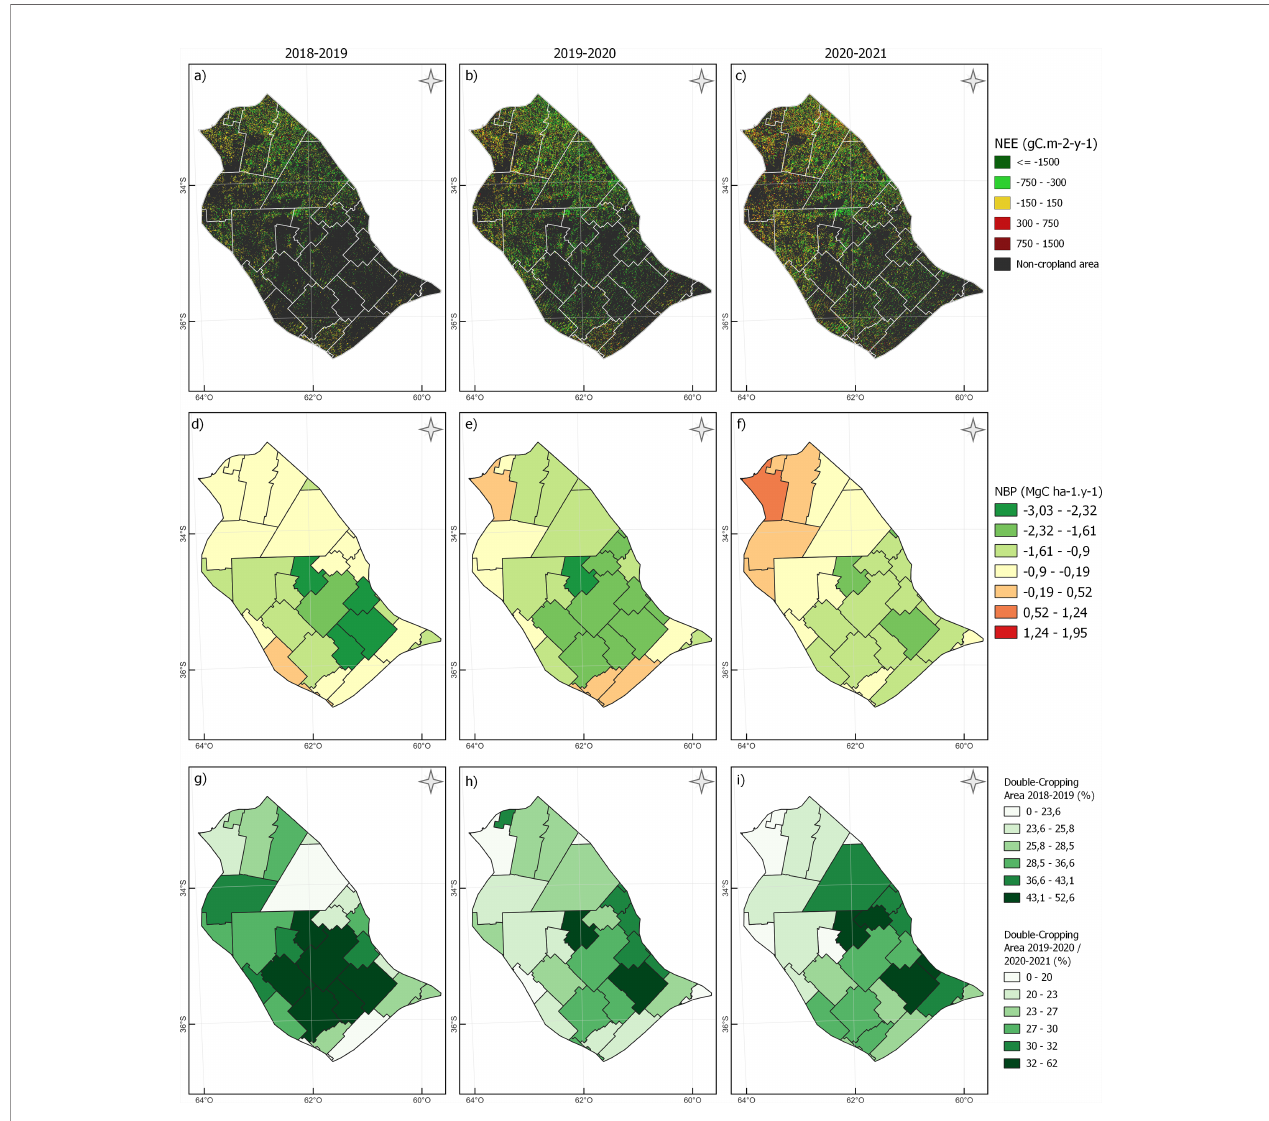
FIGURE 5 | Inland Pampa cropland area and carbon fl uxes. Upscaled NEE ( A – C ; gC m − 2 year − 1 ), NBP ( D – F ; MgC ha − 1 year − 1 ), and (G – I) double-cropping percentage area of total cropland area per county. (A, D, G) correspond to 2018 – 2019; (B, E, H) correspond to 2019 – 2020; and (C, F, I) correspond to 2020 –